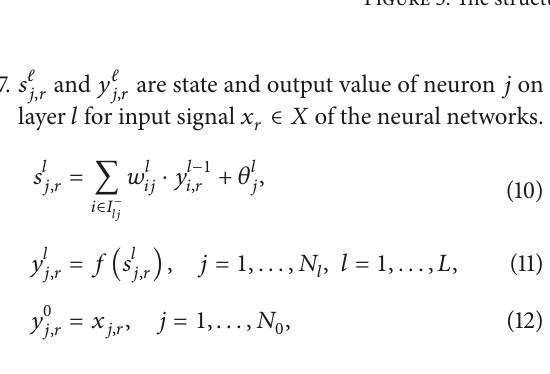
Figure 3: The structure of MANN in